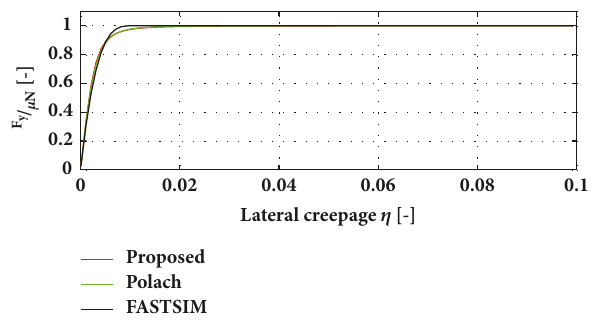
Figure 4: Lateral force versus pure lateral creepage.